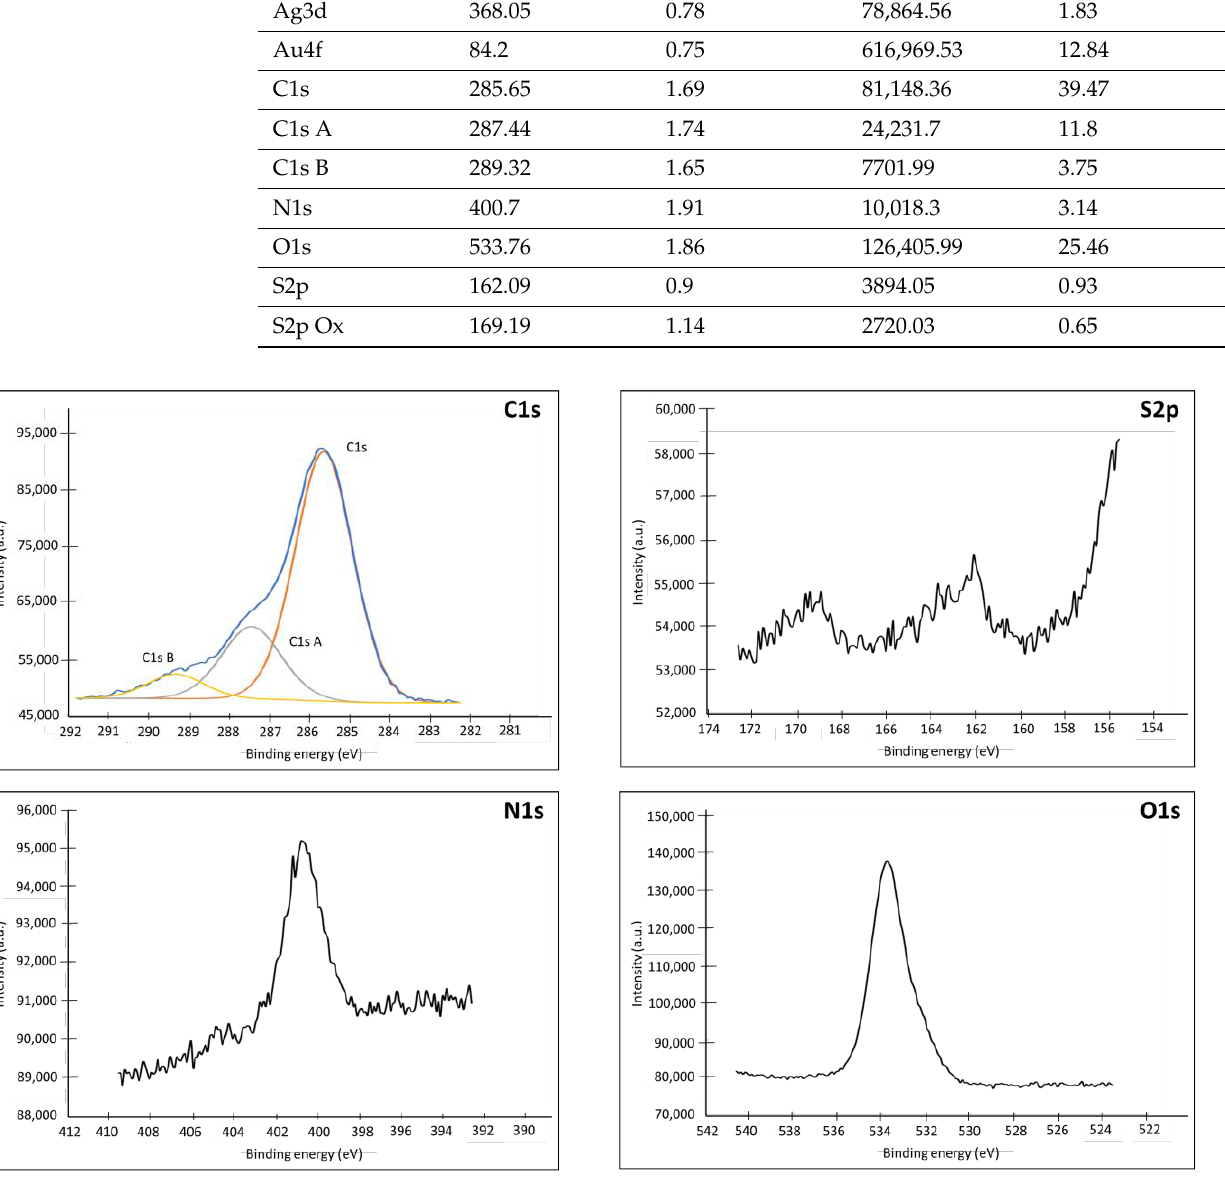
Figure A6. FTIR spectra of the Au surface functionalized with 1-azido-6-thiohexane (blue) and with DO3A-alkyne (orange). The FTIR spectra from Au is subtracted from modified surface. On the spectrum of the 1-azido-6-thiohexane-functionalized surface, the band at 2074 cm −1 corresponds to the azido group [42]; it is also visible on the spectrum of the DO3A- akyne-functionalized surface, but weaker, indicating that most but not all azido groups reacted upon coupling with the DO3A-alkyne. The red and green spectra can be super- posed, except this azido group and the-C-N group at ca. 1050 cm −1 . After coupling of the